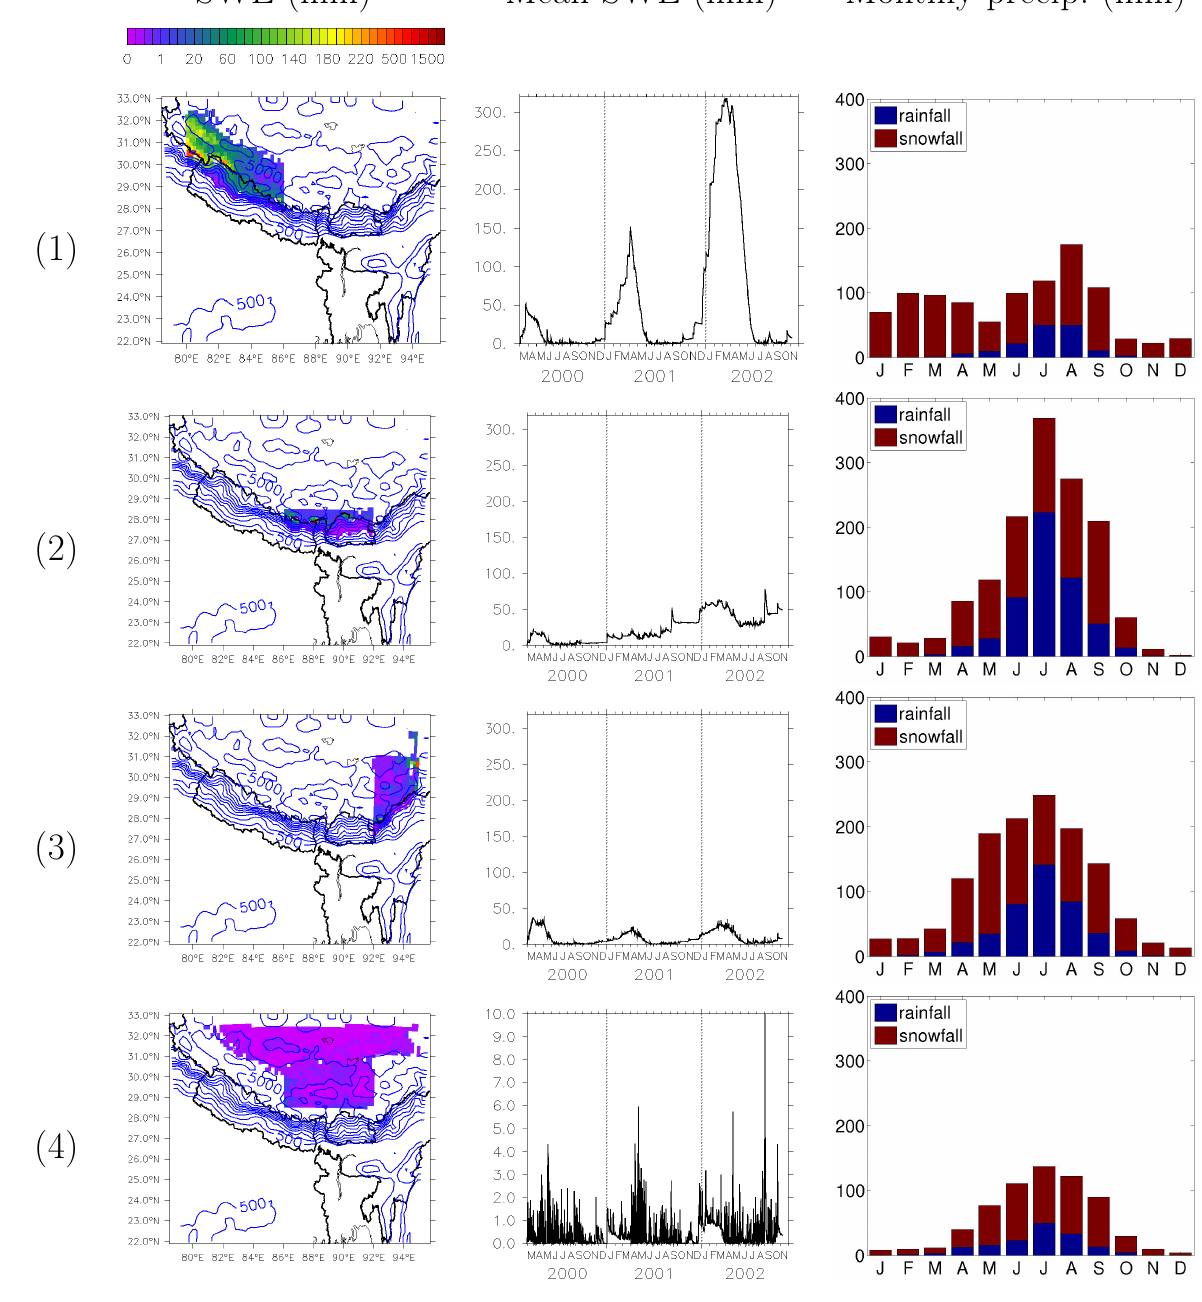
Fig. 8. Snow Water Equivalent (SWE, mm, first column), mean SWE (mm, second column) and annual cycle of precipitation (third column, monthly means of snowfall and rainfall over 2000–2002) for the domain areas coloured in the first column (subsectors numbered from 1 to 4, all altitudes exceed